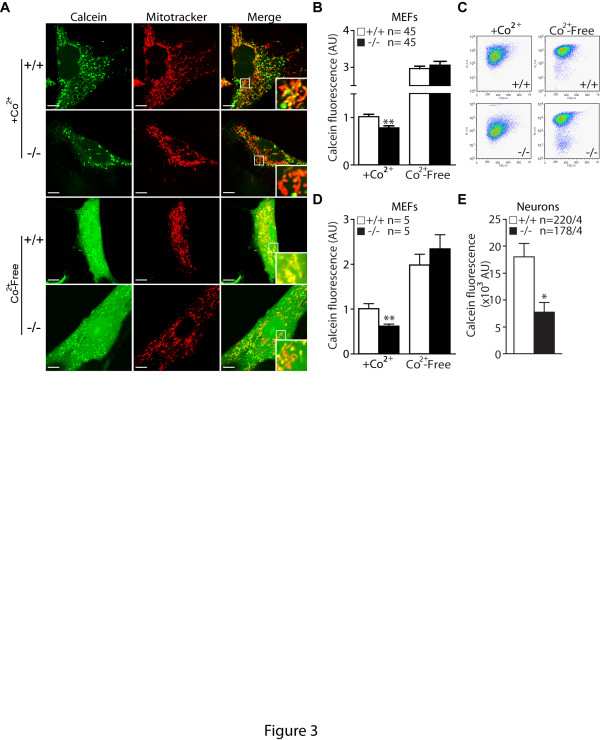
Increased opening of the mitochondrial permeability transition pore inPINK1−/− cells. A. Representative confocal microscopic images of PINK1−/− and +/+ MEFs after incubation with calcein-AM (1 μM) and Mitotracker Deep Red (150 nM) in the presence or absence of Co2+ (1 mM), which quenches calcein fluorescence (green) outside of mitochondria. Mitotracker Deep Red allows visualization of calcein fluorescence in mitochondria. The bottom right inserts are the higher power views of the boxed areas in the same panel. The calcein fluorescence in mitochondria is lower in PINK1−/− cells in the presence of Co2+. In the absence of Co2+, calcein fluorescent signals are very intense and are present in the entire cell, and there are no genotypic differences. B. The bar graph shows quantification of calcein fluorescence in PINK1−/− and +/+ cells in the presence or absence of Co2+ using confocal images. The number shown in the panel indicates the number of cells used in the study. C. Representative flow cytometry dot plots show the intensity of calcein signals in PINK1−/− and +/+ MEFs following incubation with calcein-AM (1 μM) in the presence or absence of Co2+ (1 mM). D. The bar graph of calcein signals measured by FACS analysis shows reduced calcein signals in PINK1−/− MEFs in the presence of Co2+. The number shown in the panel indicates the number of independent experiments performed. E. The bar graph of calcein fluorescent signals in PINK1−/− and +/+ neurons shows reduced calcein signals in PINK1−/− neurons. The numbers shown indicate the number of neurons used (left) and the number of independent experiments performed (right) in the study. All data are expressed as mean ± SEM. Scale bar: 10 μm. * p < 0.05, ** p < 0.01.